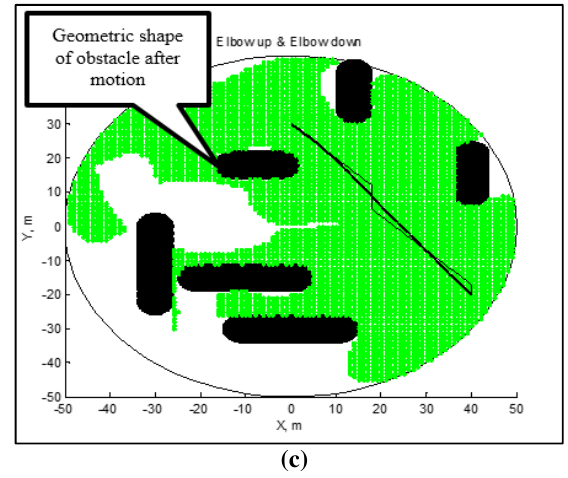
Fig. 12. FCS for known obstacle position dynamic environment where (a) represents elbow down, (b) represents elbow up and (c) represents the gathering between elbow up and elbow